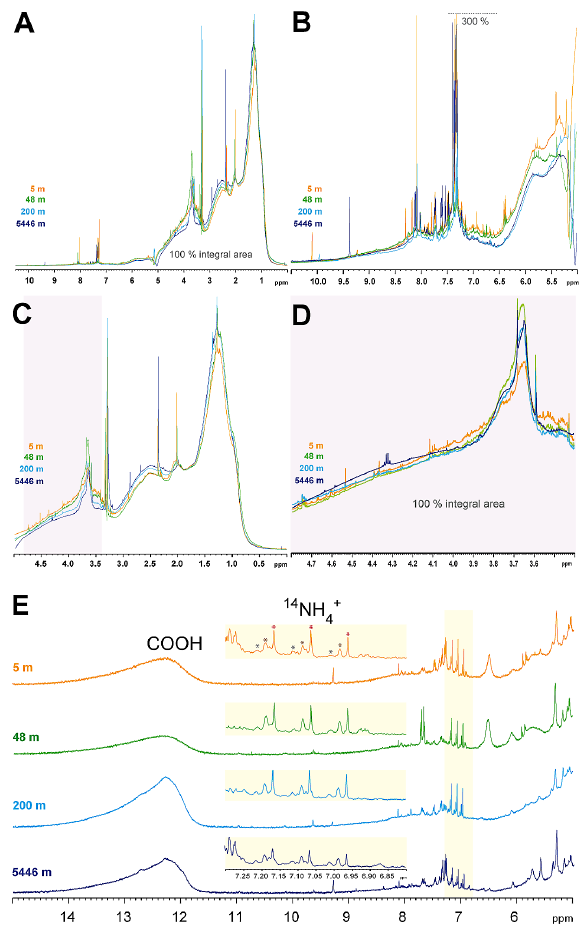
Fig. 2. (A) 1 H NMR spectra of marine SPE-DOM obtained by solid phase extraction (PPL) at different depths according to color: orange: 5m (near surface photic zone); green: 48m (fluorescence maximum); blue: 200m (upper mesopelagic zone); and dark blue: 5446m (30m above seafloor). In (A–C) , the respective spectral in- tensities were scaled to 100% total integral within the entire re- gion of chemical shift ( δ H ∼ 0–10.5ppm; with residual water and methanol excluded). (A) Entire spectral range, δ H ∼ 0–10.5ppm; (B) unsaturated protons, bound to sp 2 -hybridized carbon, δ H ∼ 5– 10.5ppm, and anomeric protons ( δ H < 5.5ppm); truncated at 33% maximum intensity; cf. Figs. S2 and S3; (C) protons bound to sp 3 -hybridized carbon, δ H ∼ 0–5ppm; (D) section of H C-O pro- tons, normalized to 100% integral within the chemical shift in- dicated ( δ H ∼ 3.4–4.8ppm); note the different relative NMR reso- nance amplitudes compared with (C) , which is normalized to the entire range of chemical shift ( δ H ∼ 0–10.5ppm). (E) 1 H NMR spectra of marine SPE-DOM in dry DMSO-d 6 , downfield section δ H > 5ppm; acquired at B 0 =11.7T, showing both exchangeable and non-exchangeable protons; aside from the large carboxylic acid NMR resonance near δ H ∼ 12.3ppm ( δ H ∼ 11.6–14.7ppm), a min- imum of three different ammonium ( 14 NH + ) chemical environ- 4 ments were observed near δ H ∼ 7.07ppm with an ostentatious cou- pling between 14 N and 1 H ( 1 J NH = 51.2Hz; 1 : 1 : 1 triplet, be- cause of nuclear spin for 14 N=1, denoted with colored